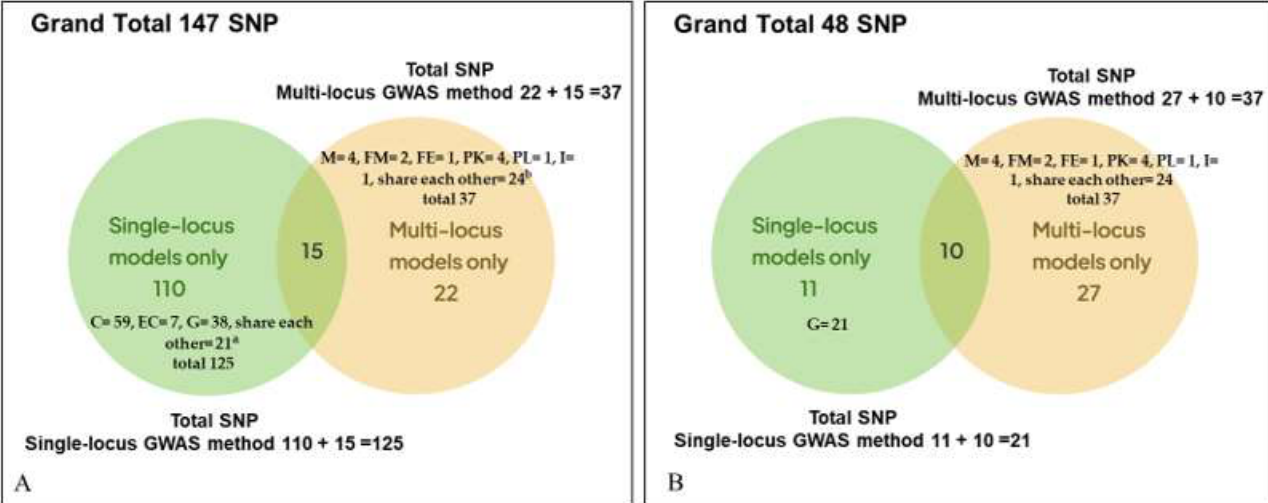
Figure 4. Venn diagrams show the number of SNPs identified by single-locus and multi-locus meth- ods for the six mineral elements ( A ) before and ( B ) after applying multi-test correction. Abbreviations: Single-locus GWAS models-C = CMLM (Compressed Mixed Linear Model); EC = Enhanced Compressed Mixed Linear Model; G = GEMMA (Genome-wide Efficient Mixed Model Association). Multi-locus GWAS models- M = mrMLM (Multi-locus random-SNP-effect MLM); FM = FASTmrMLM (fast mrMLM); FE = FASTmrEMMA (fast multi-locus random-SNP-effect efficient mixed model analysis); PK = pKWmEB (integration of Kruskal–Wallis test with empirical Bayes); PL = pLARmEB (polygenic background-control-based least angle regression plus empirical Bayes); I = ISIS EM-BLASSO (iterative modified-sure independence screening expectation-maximization-Bayesian least absolute shrinkage and selection operator). a = list of shared SNPs among three models; C ∩ EC = 2